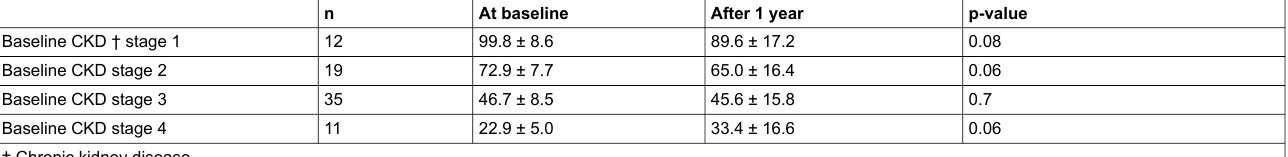
Table 5: p-values in diabetic patients 0.5 between baseline and 1 year, 0.06 between baseline and 2 years; in nondiabetic patients 0.3 between baseline and 1 year, 0.01 between baseline and 2 years. n At